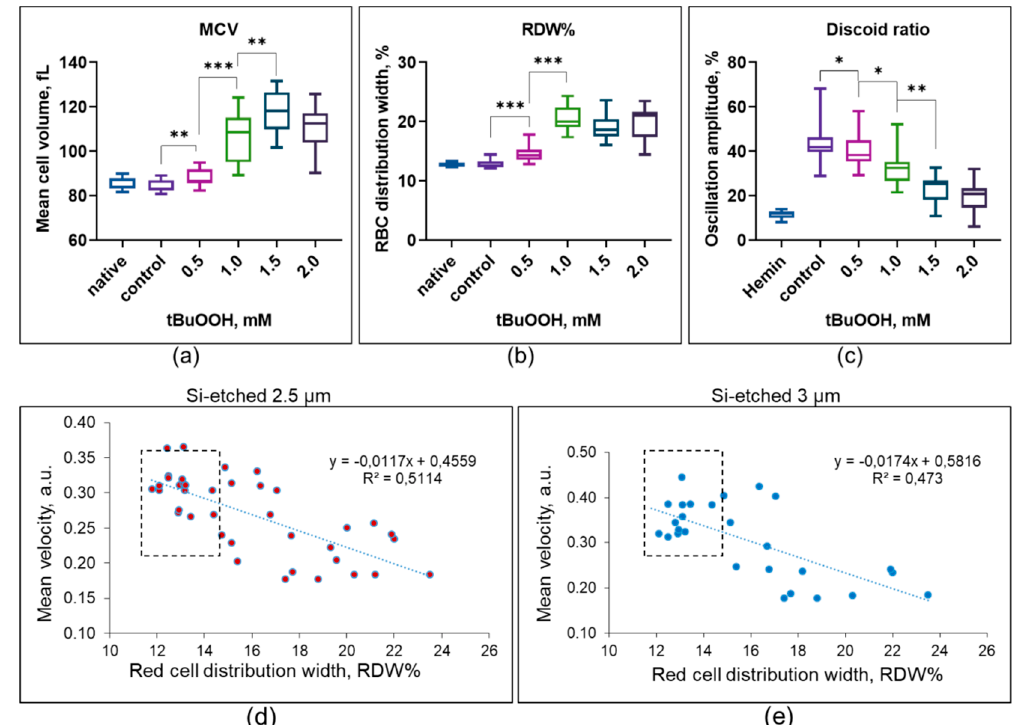
Figure 4. Hematological analysis of erythrocytes exposed to oxidative stress caused by tBuOOH show: ( a ) increase of mean cell volume; ( b ) increase heterogeneity of the population by volume; ( c ) decrease of low angle light scattering oscillations indicating increase in RBCs spherization. * p < 0.05; ** p < 0.01; *** p < 0.00; 2-tailed independent samples, t -test, n = 14 donors. ( d ) The relationship between the RBCs mean velocity in microchannels and the indicator of the heterogeneity of the RBC population by volume, RDW% in 2.5 µm-wide channels and ( e ) in 3 µm-wide channels; RDW%—hematological analyzer data; the dashed field shows the values for RDW% and mean velocity of untreated by tBuOOH cells.